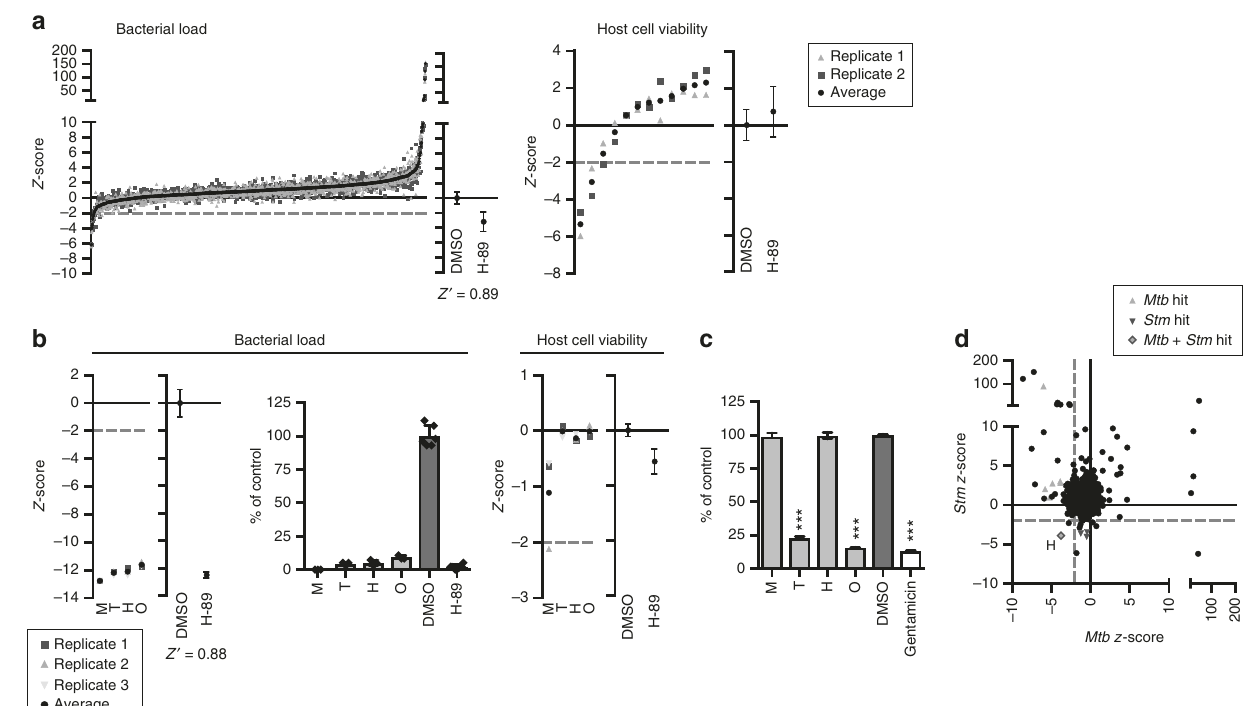
Fig. 3 Identi fi cation of host-directed compounds inhibiting Stm . a Screen of the LOPAC library in the HeLa- Stm infection model using Stm constitutively expressing stable DsRed, as in Fig. 2a. b Rescreen of the hit compounds from the HeLa- Stm screen that were superior to H-89 without affecting cell viability, displayed as in Fig. 2b. The bacterial load is expressed as a z -score in the utmost left panel and as a percentage of control value ± standard deviation in the middle panel to indicate the extent of bacterial inhibition. Compound abbreviations: T = trimethoprim, H = haloperidol, M = mibefradil, O = o fl oxacin. c Overnight treatment of a Stm broth culture with the hit compounds at 10 µ M. Gentamicin (50 μ g/ml) was used as a positive control. The average bacterial density ± standard deviation of six replicates from a representative experiment out of three experiments is shown. The bacterial load is expressed as a percentage of the DMSO control value to indicate the extent of bacterial inhibition. Statistically signi fi cant difference compared to DMSO was tested using a one-way ANOVA (F (5,30) = 4871; *** p value < 0.001). d Comparison of the Stm and Mtb primary screening data. Compounds that were superior to H-89 and subsequently con fi rmed in a rescreen are indicated in gray triangles. H =